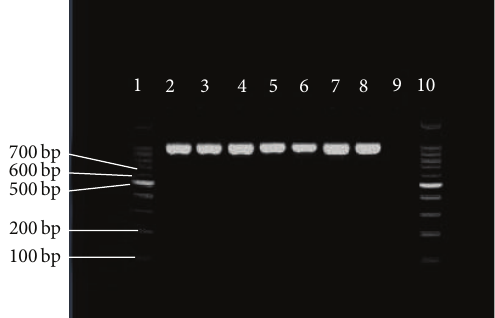
Figure 3: PCR results of pilB . 1, 10 = marker = 100bp; 2–8 = pilB = 959 bp; 9 = negative control.